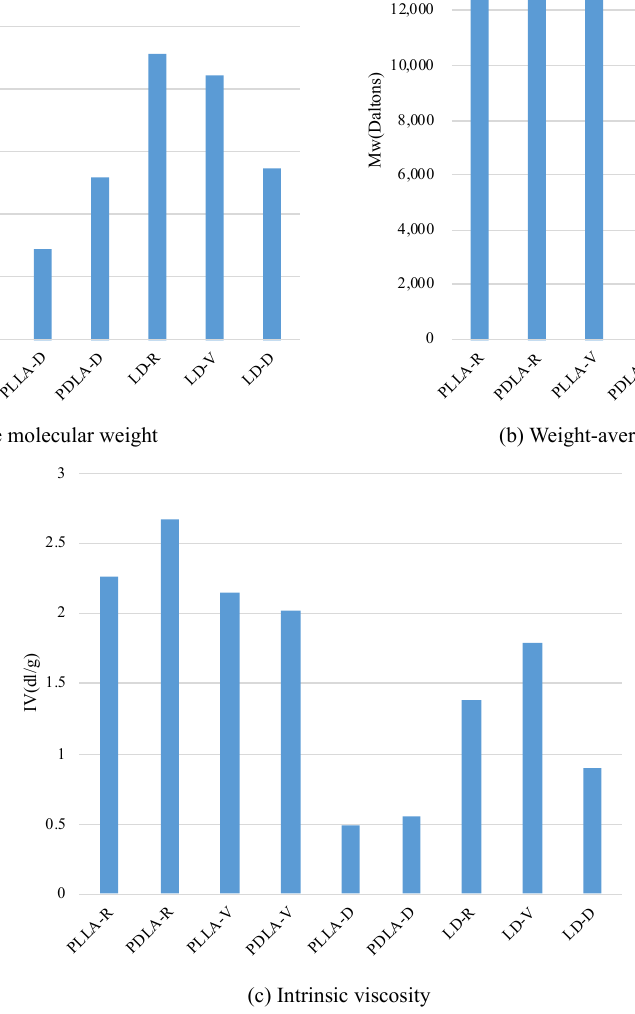
Figure 5. ( a ) M n ; ( b ) M w ; and ( c ) intrinsic viscosity (I.V.) of PLLA, PDLA, and LD.